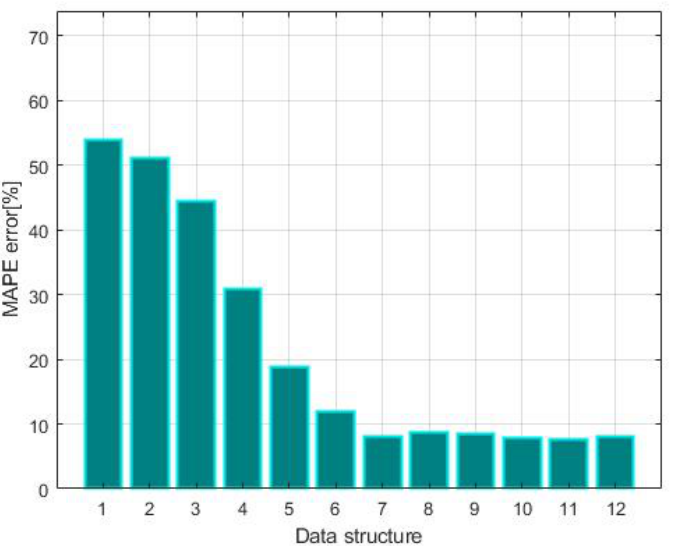
Figure 32. Comparison of data structures for wind power plant FW4, MAPE error.